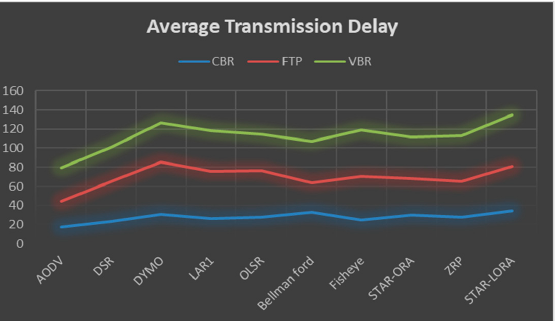
Figure 15. Receive mode energy consumption of all routing protocols for 120 nodes.